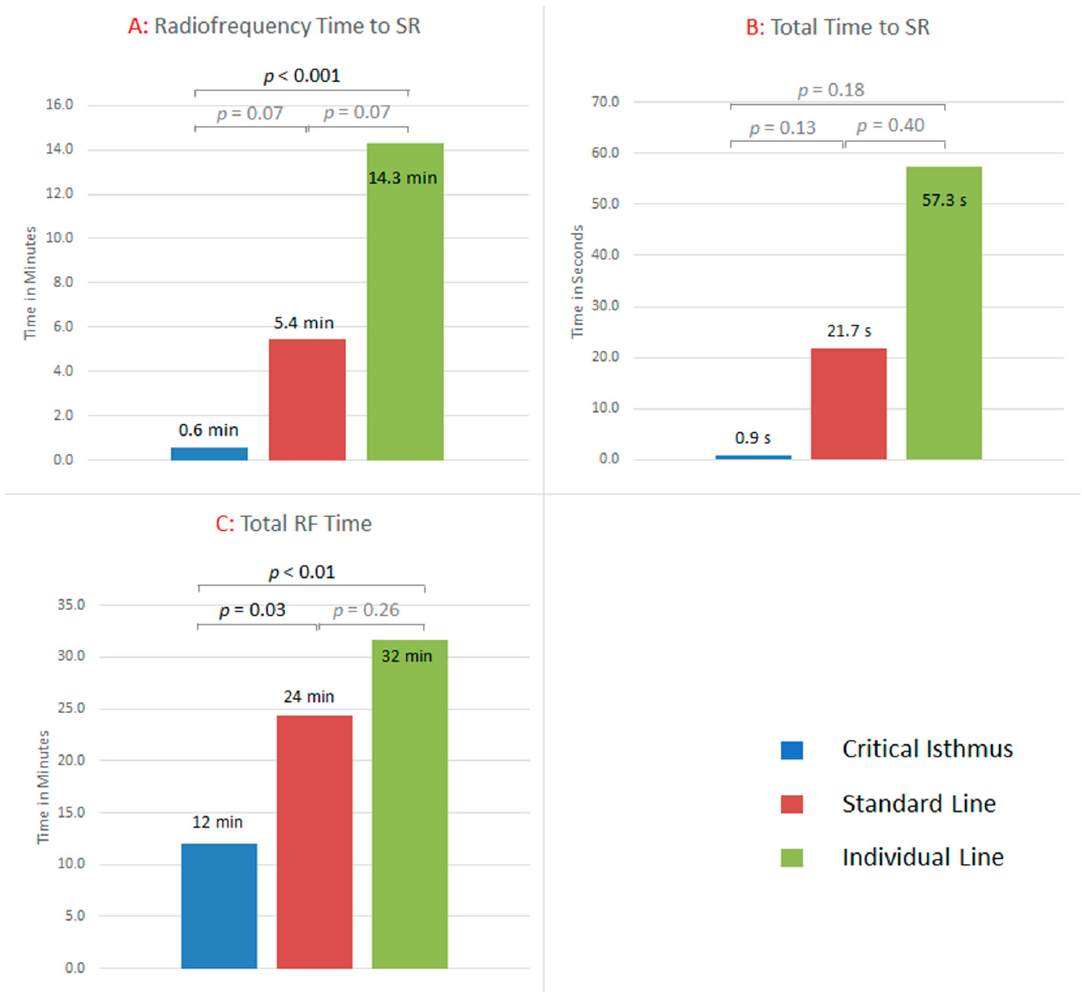
Figure 5. ( A ): RF time from the start of the first ablation until the termination in SR. For critical isthmus, individual line, and standard line, the RF time was 1 ± 1 min, 5 ± 9 min, and 14 ± 12 min, respectively. Standard lines took significantly longer compared to critical isthmus ablation ( p < 0.001). ( B ): The total time to SR was 1 ± 1 min, 22 ± 49 min, and 57 ± 100 min, respectively. Differences